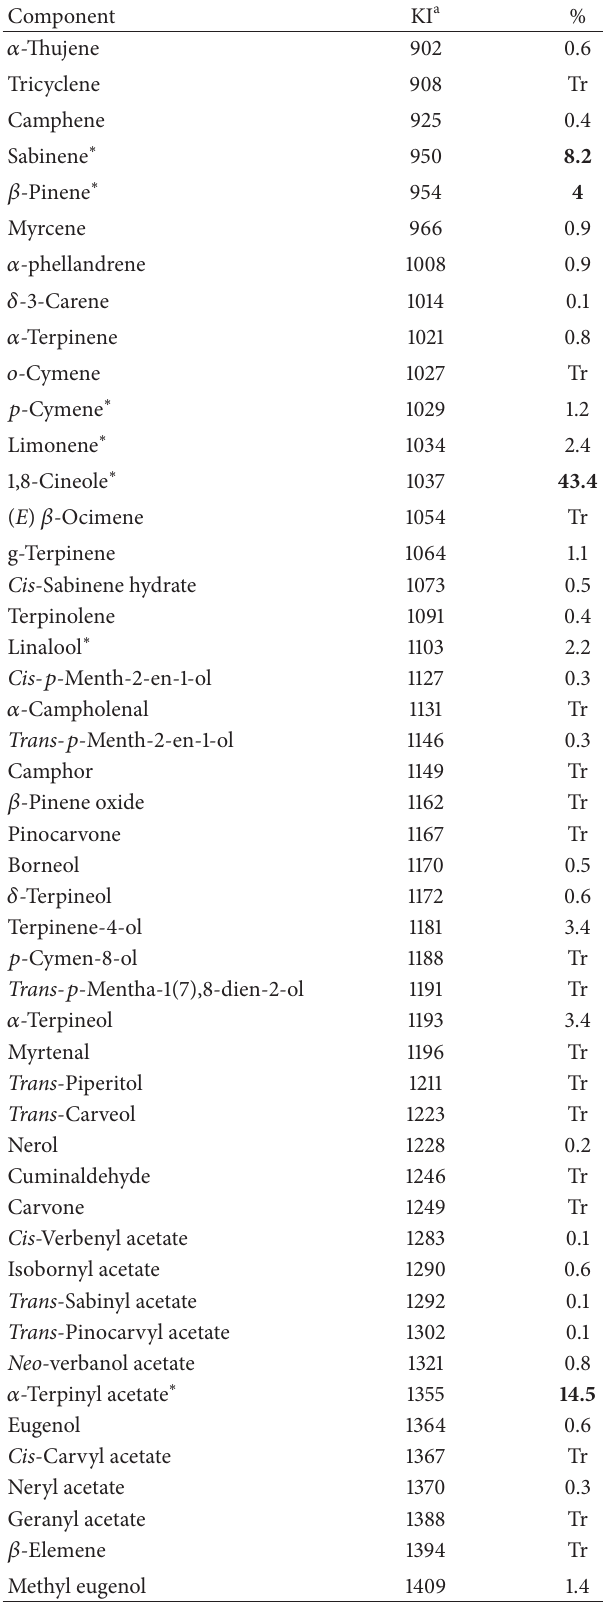
Table 1: Retention index and relative composition of major chemi- cal components of M. lucida essential